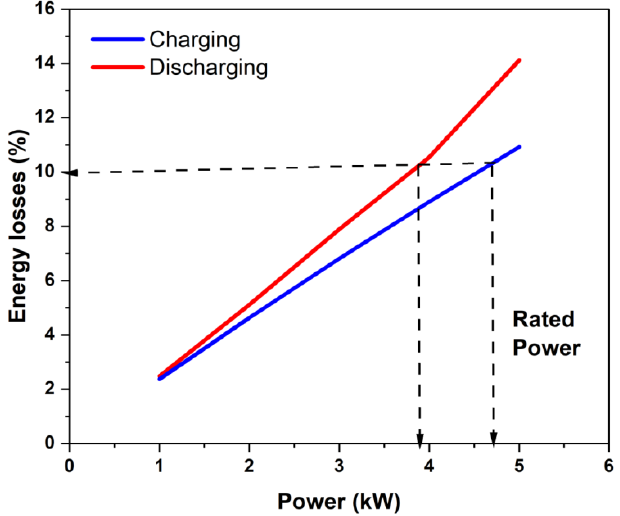
Figure 9. Estimation of the stack power rating of the present stack during charging and discharging when using 10% energy loss in each process as the criterion for the power rating.